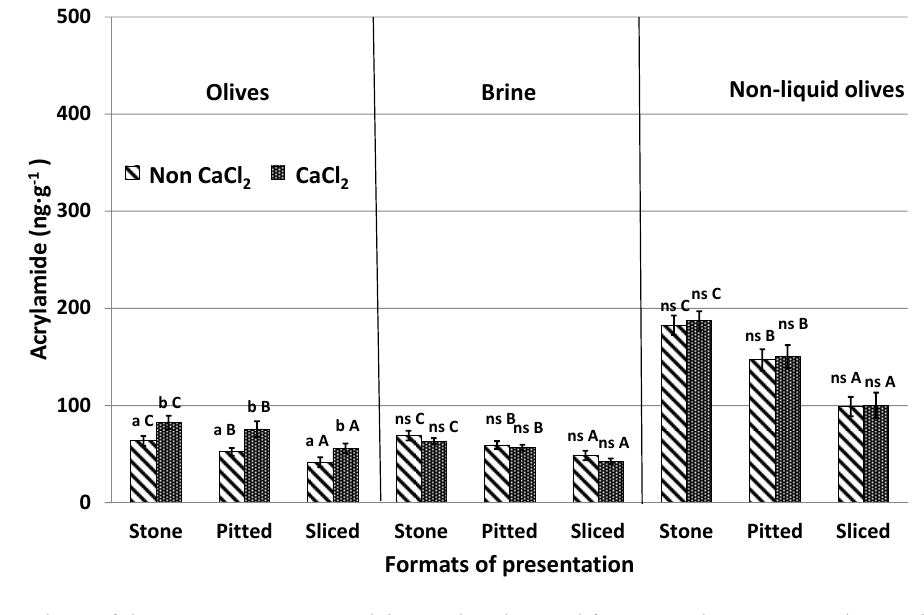
( c ) Olives of the “Cacereña” variety elaborated such as Californian-style green ripe olive with different presentation formats and with or without the addition of CaCl 2 to the brine. Figure 4. Acrylamide content (ng g − 1 ) of olives and brine obtained from different olive presentation formats (stones, pitted, sliced), with or without the addition of CaCl 2 to brine after the sterilization process. Results are expressed as means ± SD of five sample replicates. Superscript indicates statistically significant differences relating to CaCl 2 addition (Tukey test, p < 0.05). Different capital letters in the same columns indicate statistically significant differences between different olive presentation formats (Tukey test, p < 0.05). ns: no significant differences.